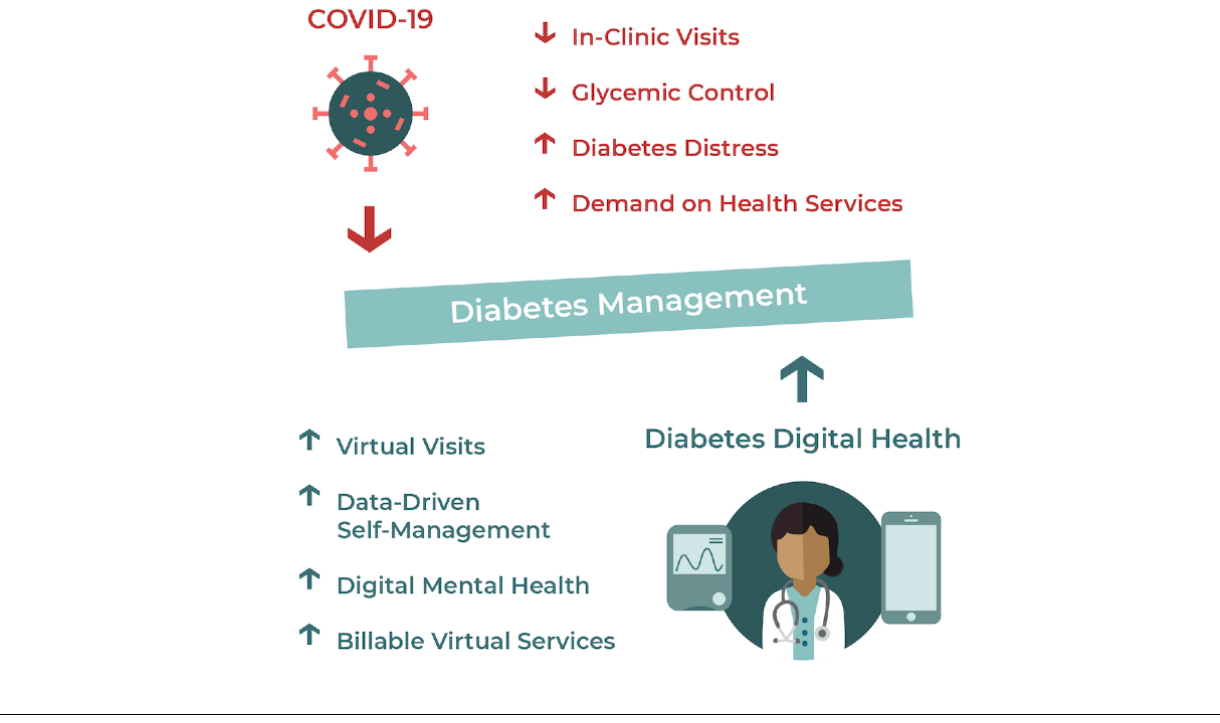
Figure 1. The challenges of COVID-19 for people living with diabetes and the opportunities of diabetes digital health.